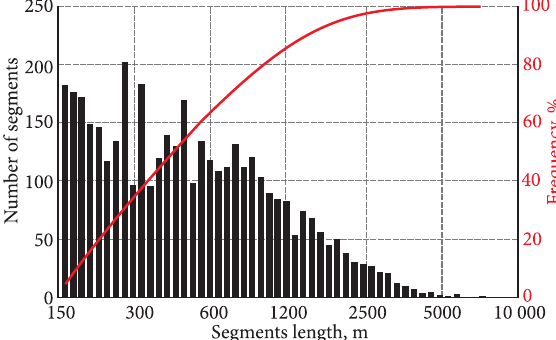
Fig. 3. Distribution of 4070 segment lengths